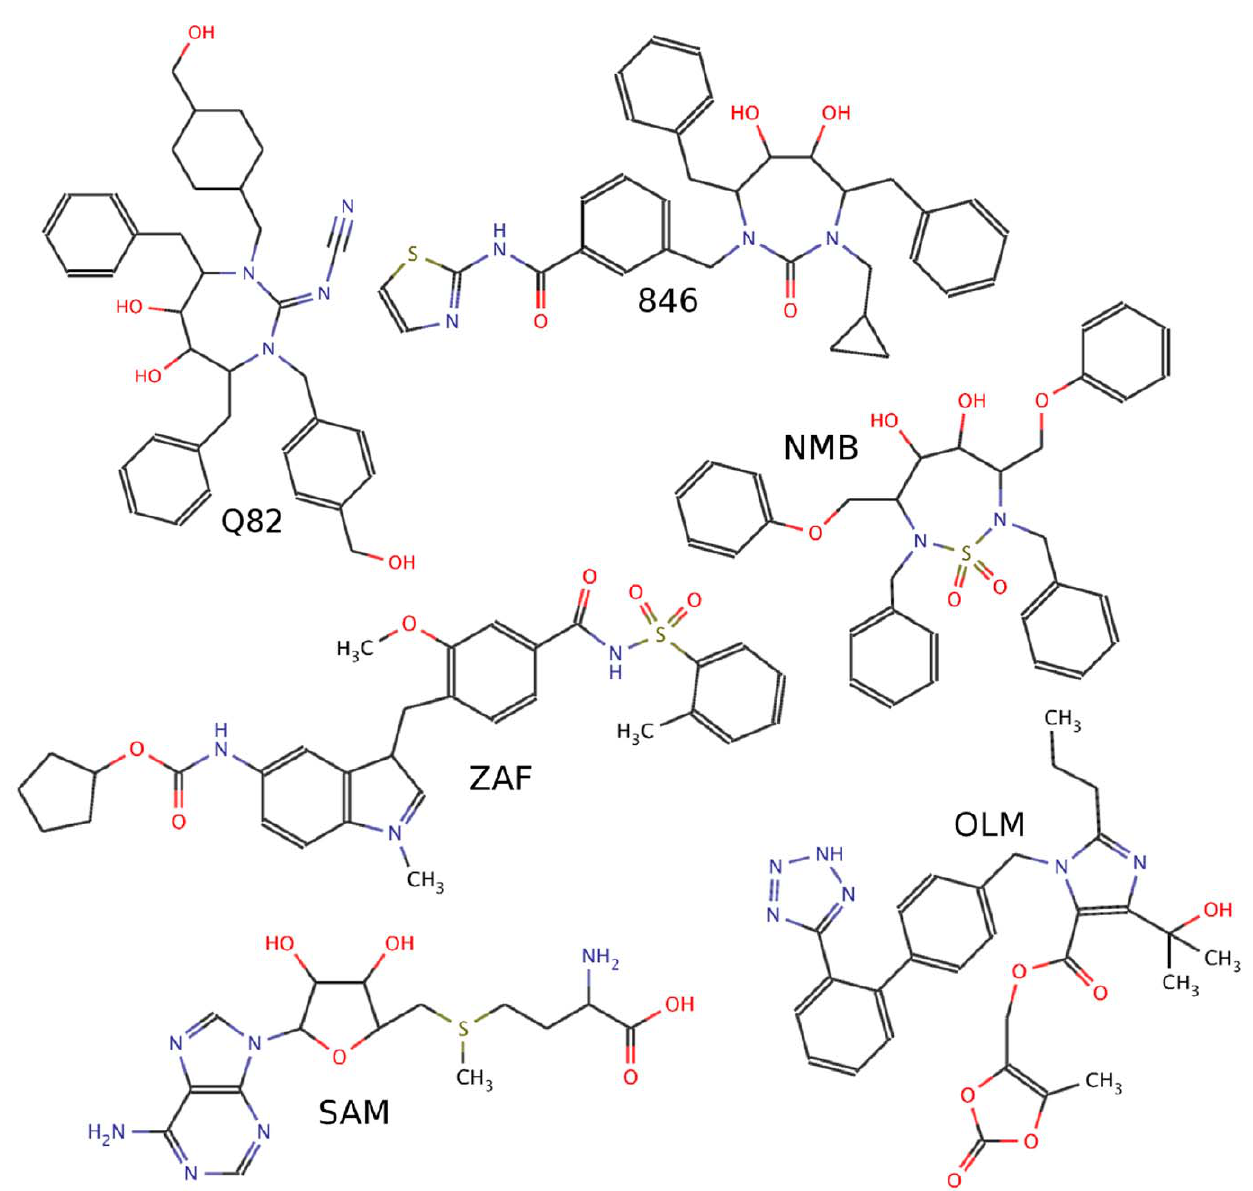
Figure 2. Examples for the used ligand test-sets. Sample chemical structures of HIV-1 protease binding ligands (binders: Q82, NMB and 846), and non-binders of similar size and composition (ZAF, OLM, SAM) used in the ligand test-set. The complete ligand test sets are listed in Figure S1.